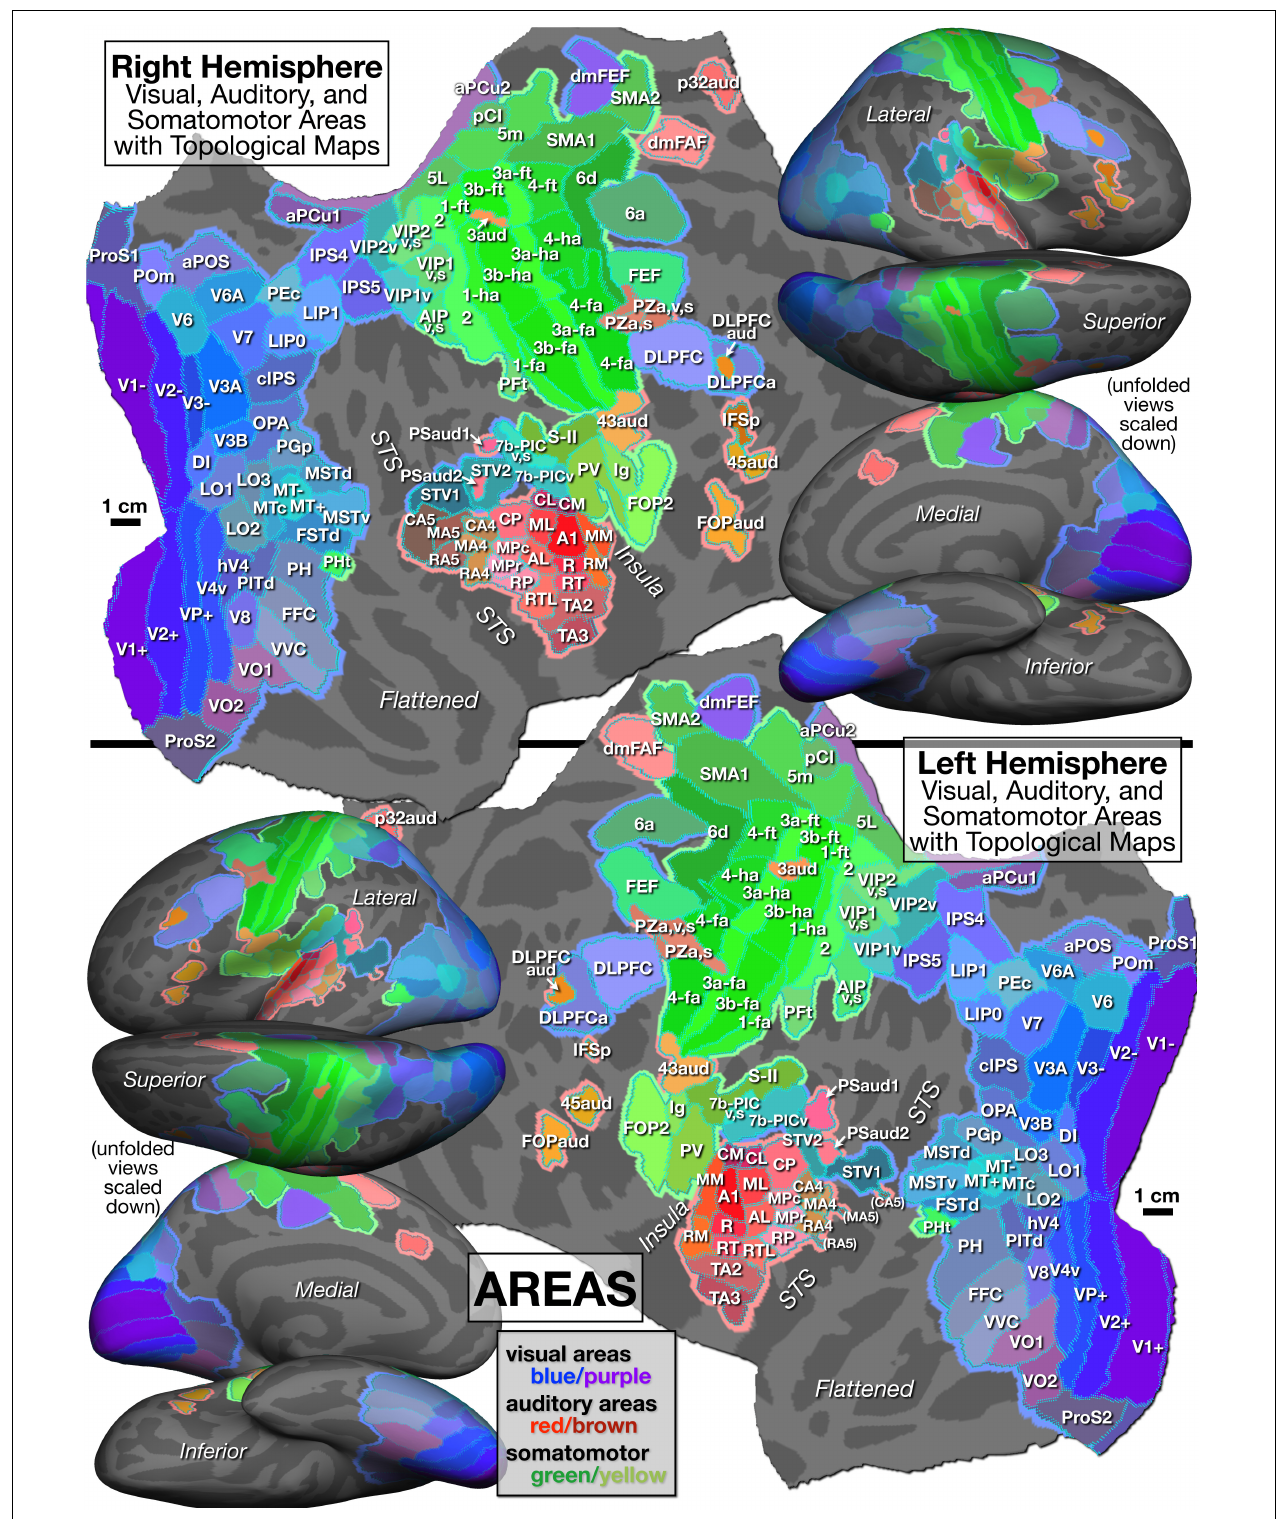
FIGURE 5 | Parcellation of cortical areas containing topological sensorimotor maps as defined by significant amplitude response and significant phase spread to phase-encoded visual (blue/purple), auditory (red/brown), and somatomotor (green) mapping stimuli. See identically arranged Figure 6 for supporting mapping data and Table 1 for abbreviation